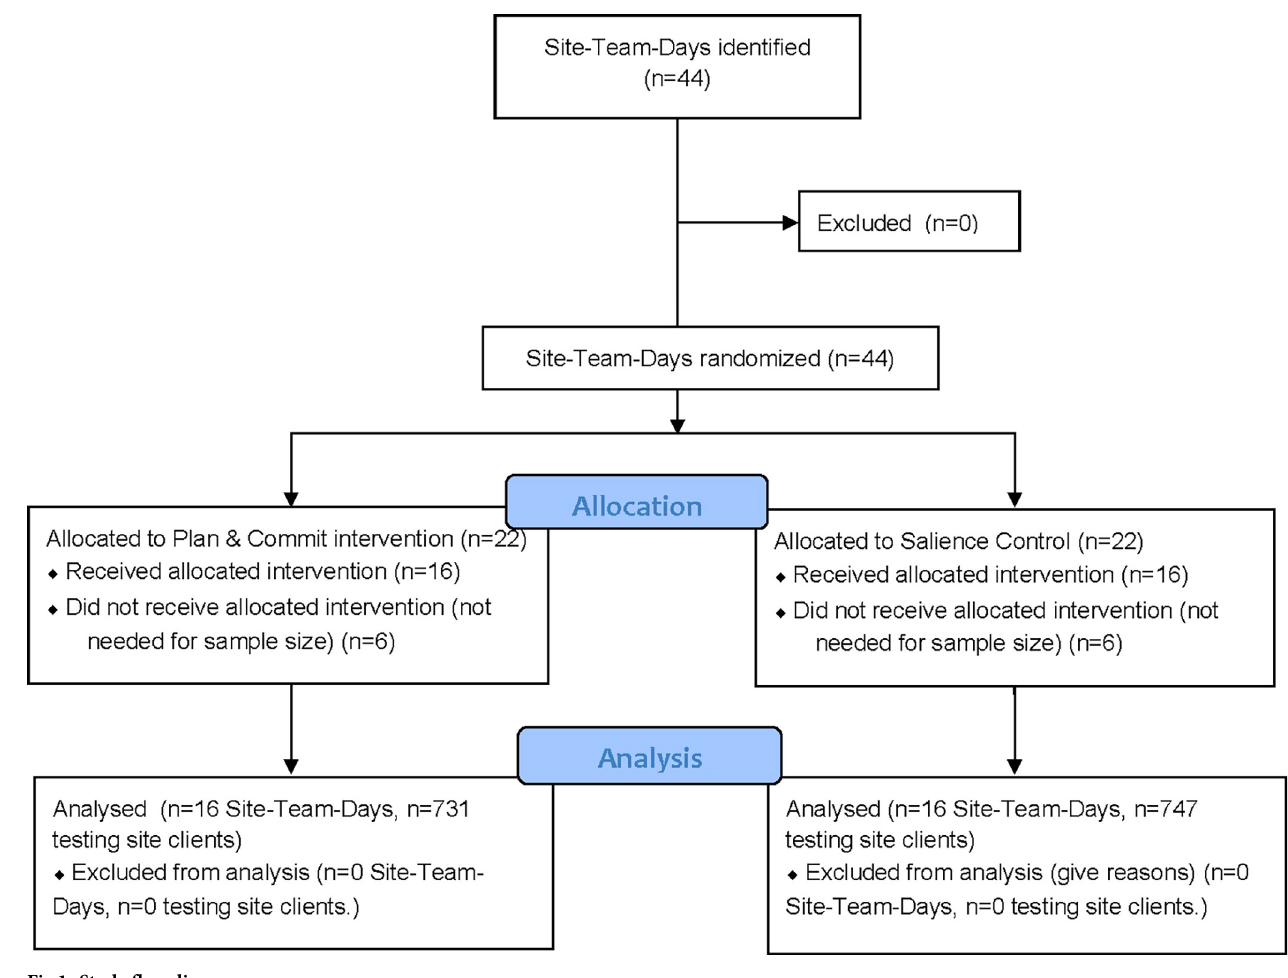
Fig 1. Study flow